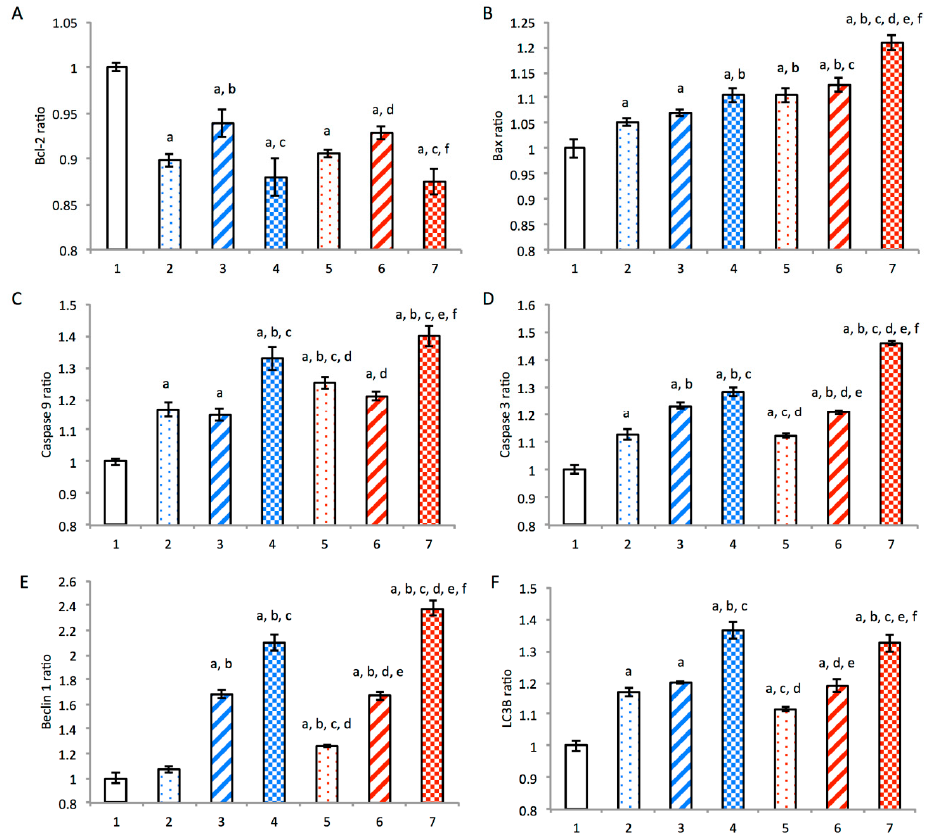
Figure 4. Mechanisms of autophagy and apoptosis in breast cancer MDA-MB-435S cells. 1, blank control; 2, free dihydroartemisinin; 3, free epirubicin; 4, free dihydroartemisinin plus epirubicin (mole ratio = 2:1); 5, dihydroartemisinin liposomes; 6, epirubicin liposomes; 7, dihydroartemisinin plus epirubicin liposomes. Data are presented as the mean ± standard deviation ( n = 3). p < 0.05; a, vs. 1; b, vs. 2; c, vs. 3; d, vs. 4; e, vs. 5; f, vs. 6.